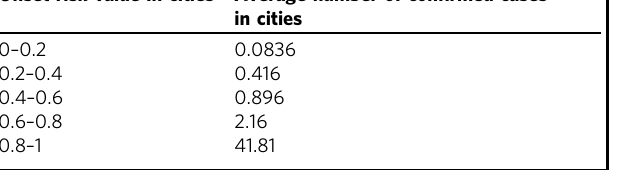
Table 3 The number of cities, at different onset risk levels, under two scenarios (i.e. with and without Wuhan lockdown measure) on the dates corresponding to Fig. 2e – j.